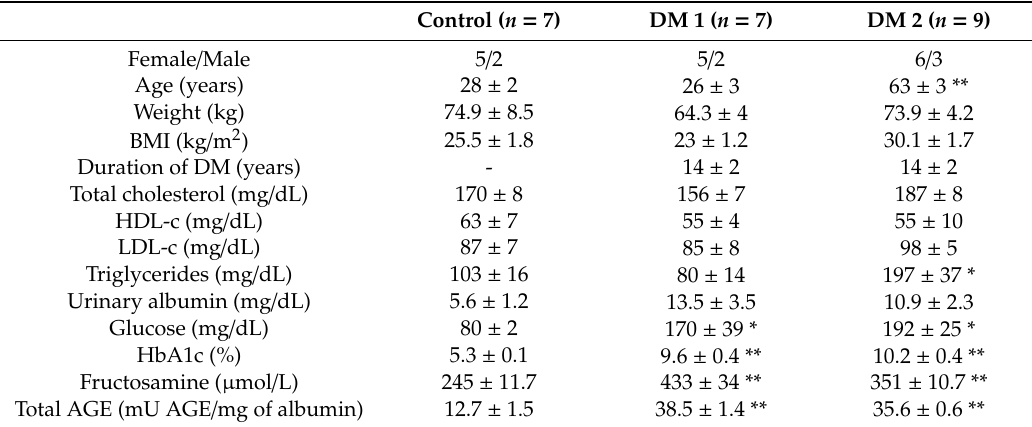
Table 1. Clinical and biochemical data from control, DM 1 and DM 2